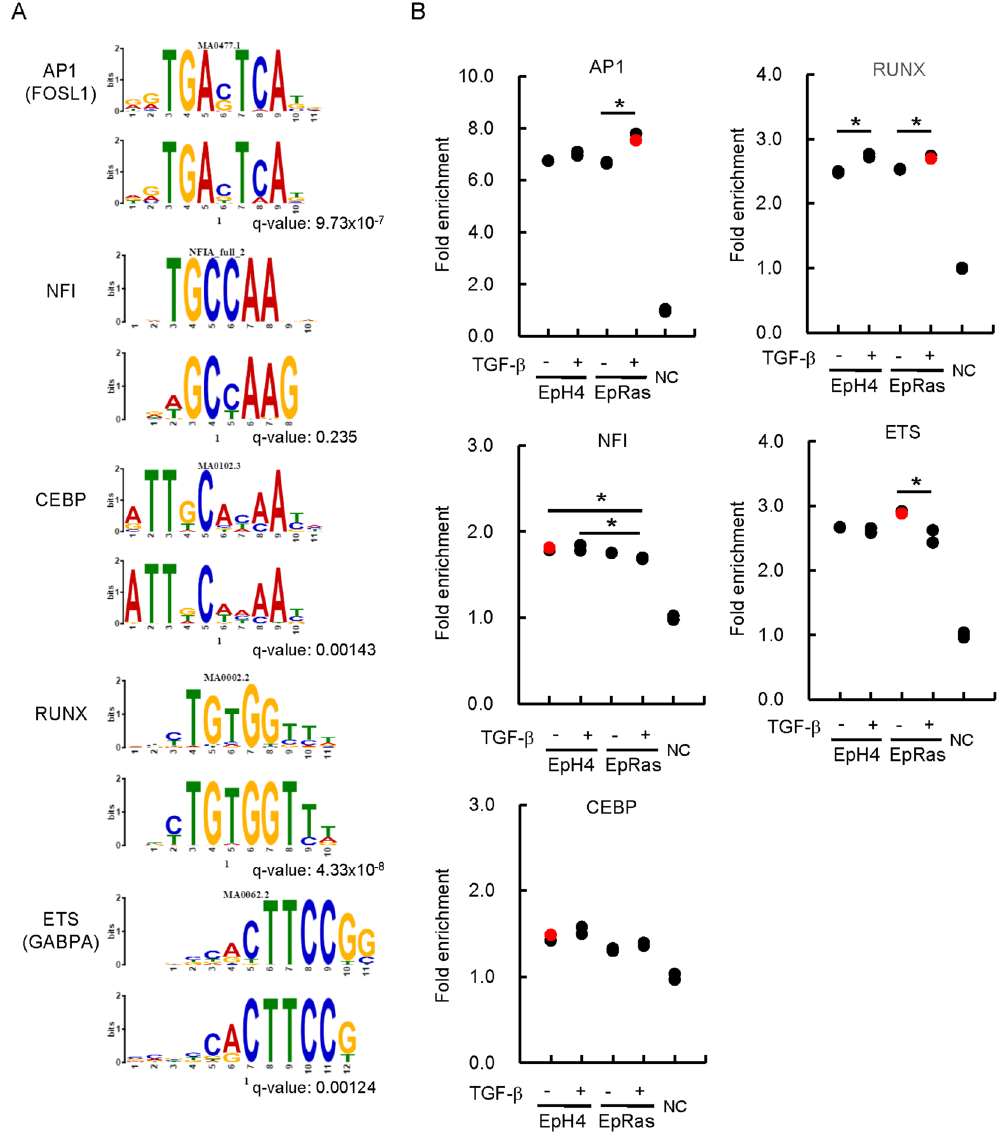
Figure 3. Motif enrichment analysis of the context-specific FAIRE-positive regions of EpH4 and EpRas cells. ( A ) De novo motif prediction of accessible chromatin regions. After exclusion of promoter regions and the sequence repeat areas, 500 bp sequences flanking the middle position of each FAIRE peak region were analyzed using the Gibbs motif sampler function of CisGenome. The following parameters were used: K = 15, mean length lambda = 10 bp, and maximal length = 20 bp. Alignments to the known transcription factor binding motifs are shown as sequence logos (upper panel for each motif, most similar known motifs identified by TOMTOM; lower panel for each motif, motifs calculated from FAIRE-positive regions). q value (minimal false discovery rate required to include the motif) is shown for each motif. ( B ) Fold enrichment values of the identified motifs were calculated compared to two sets of matched control genomic regions picked up by Gibbs motif sampler (NC). Red dots show the datasets from which the motif was identified in ( A ). * p < 0.05. Note that the enrichment of every motif was significantly higher than the control genomic regions in all four samples, and the results of statistical analyses were omitted for